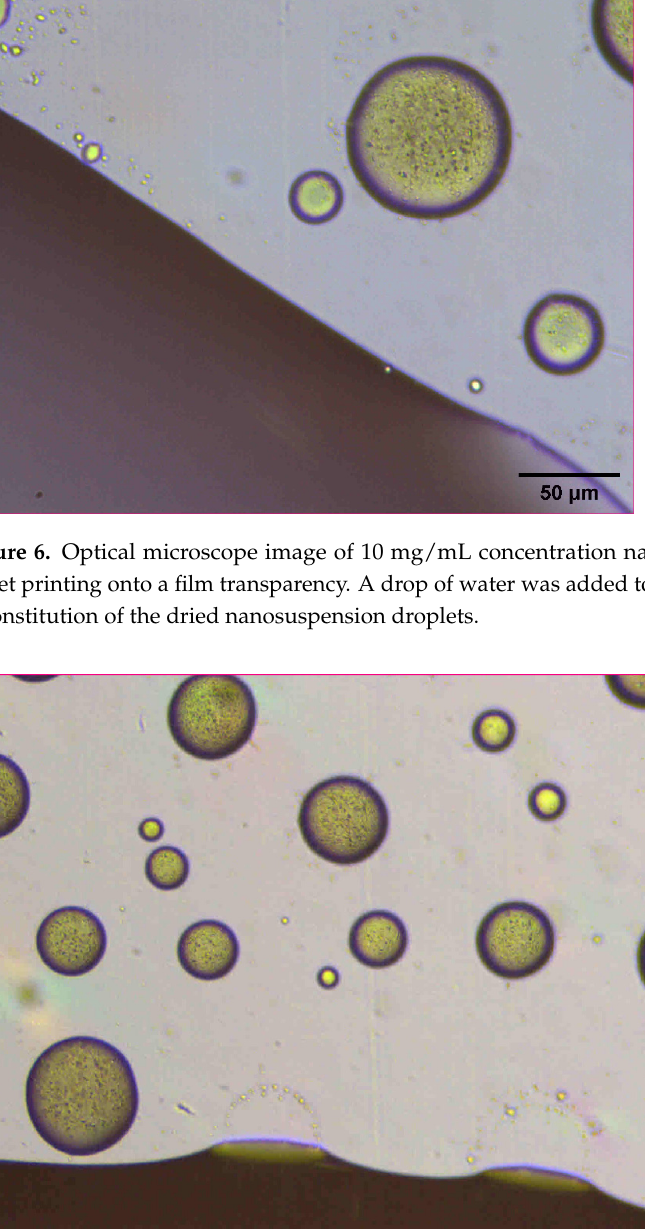
Figure 8. Optical microscope image of 10 mg/mL concentration naproxen nanosuspension after inkjet printing onto a film transparency. A drop of water was added to observe the redispersion of the dried nanosuspension droplets.